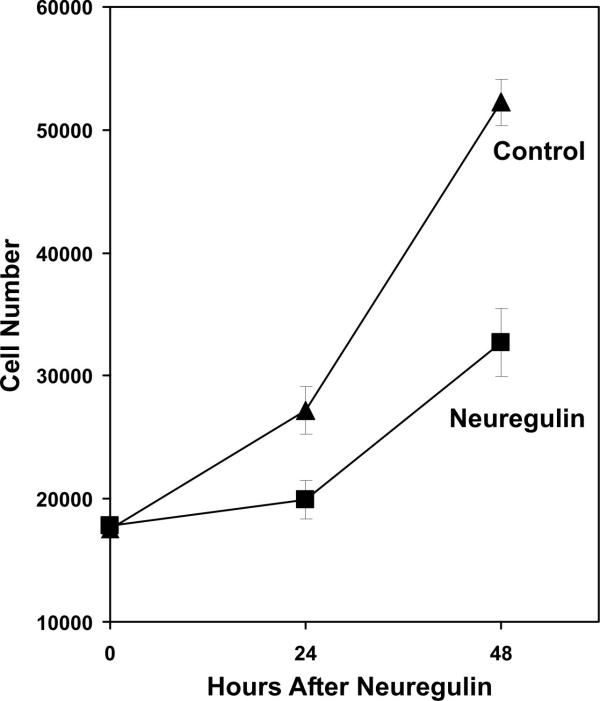
Anti-proliferative effects of neuregulin on MCF10AT cells. Quadruplicate cultures of MCF10AT cells were treated with and without 1 nM neuregulin 3 days after plating and cell counts were performed demonstrating a significant decrease in their growth 24 and 48 hours after treatment. The p value for 24 hr was 0.0011, and for 48 hr was 1.46E-05.